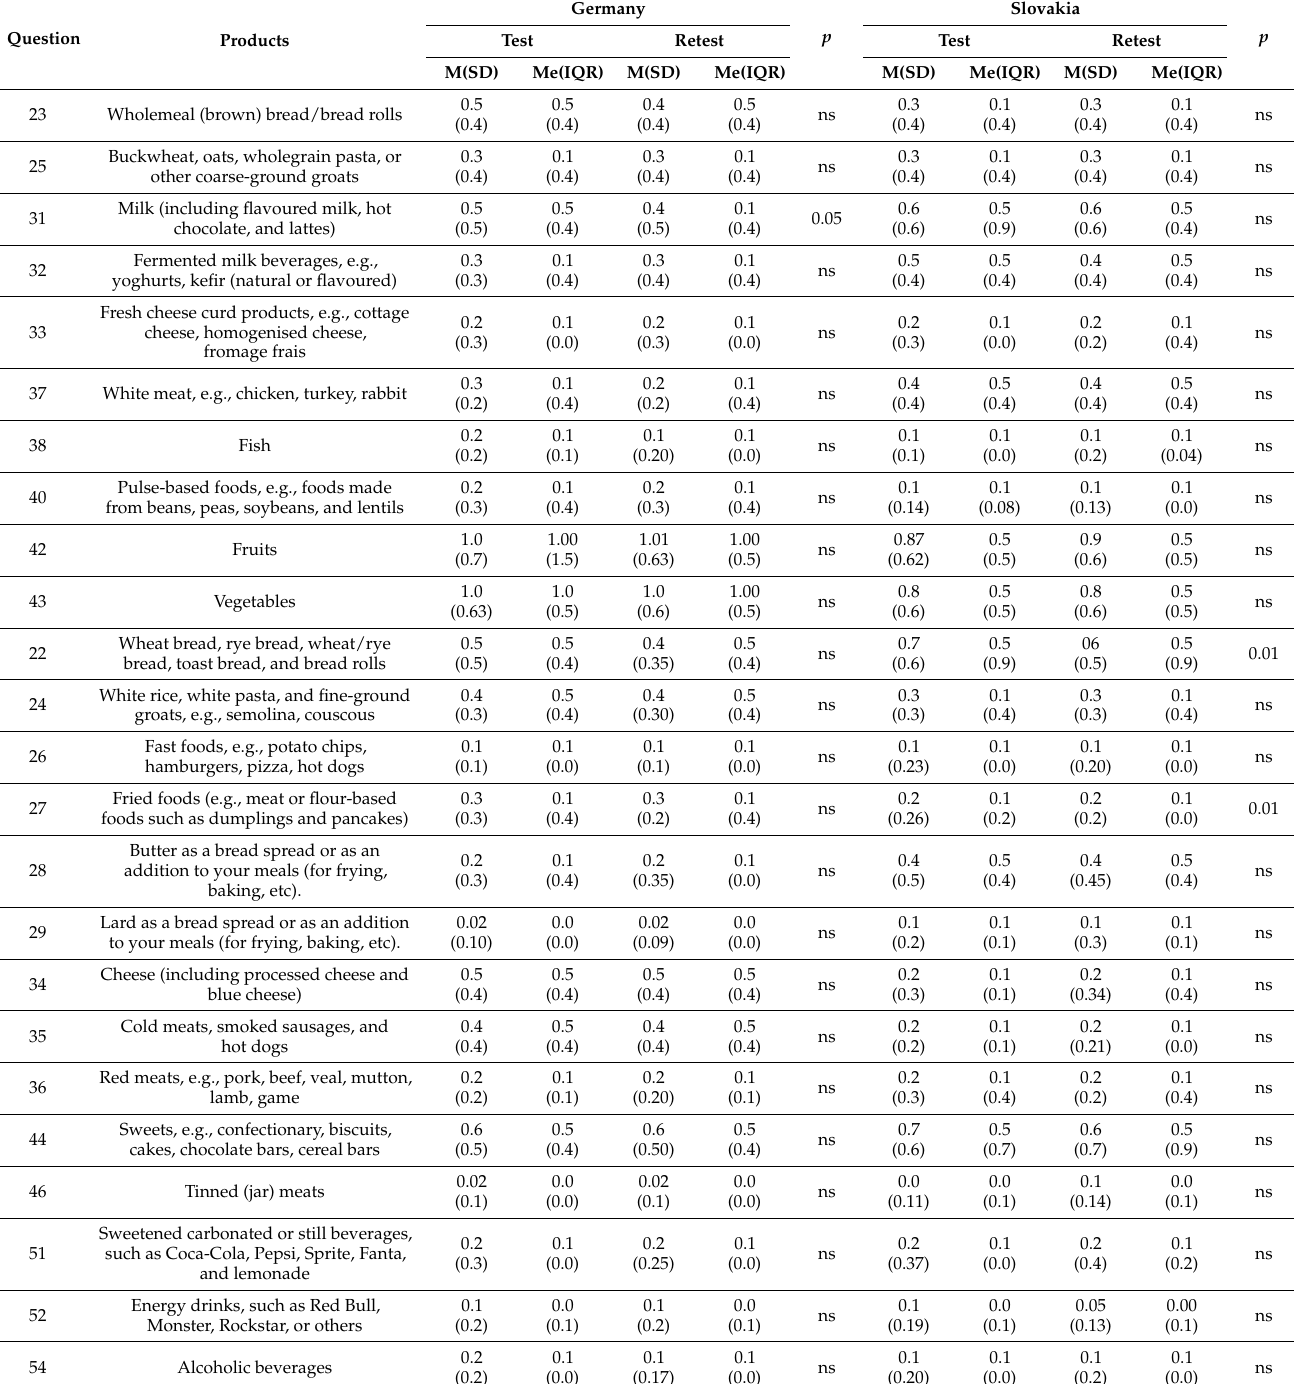
Table 2. Study participants’ dietary habits in the test and the